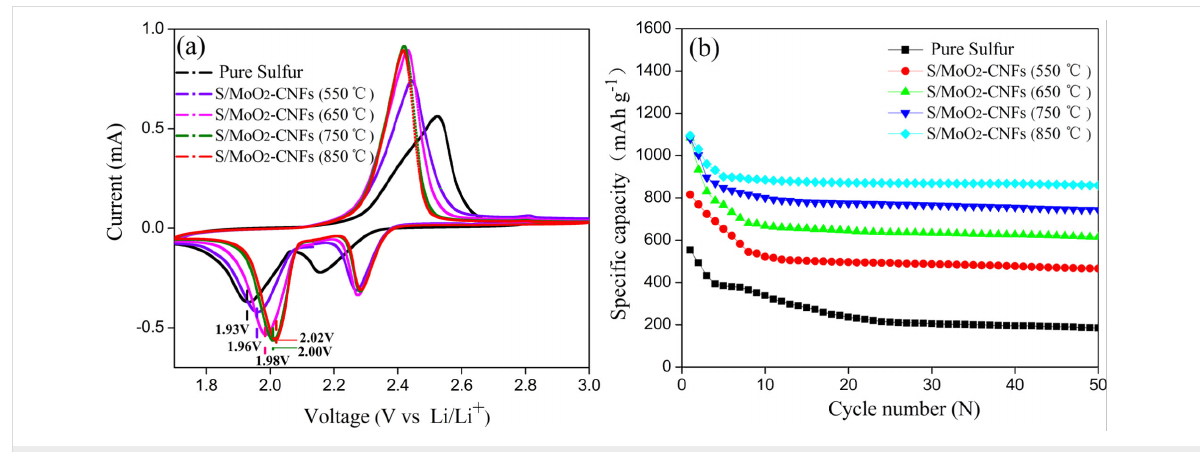
Figure 5: (a) The CV curves of cells assembled with S/MoO 2 –CNF cathodes and pure sulfur cathodes. (b) Cycling performance of MoO 2 –CNFs calcined at different temperatures with S/composite cathodes and pure sulfur cathode at 0.25 mA cm − 2 .